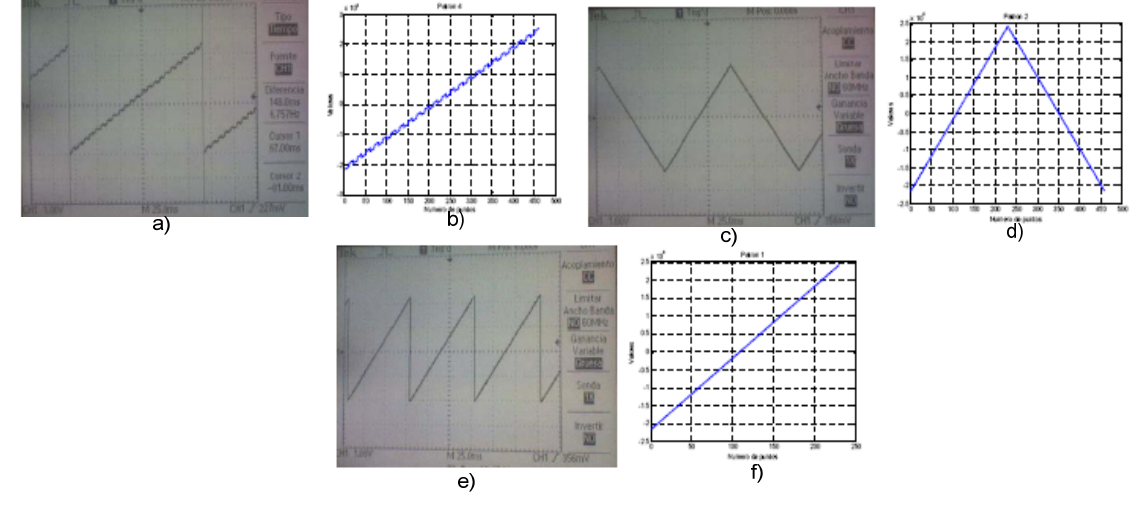
Figure 5. Generated patterns. (a) , (c) , (e) correspond to the analog patterns (obtained). (b) , (d) and (f) correspond to computed patterns